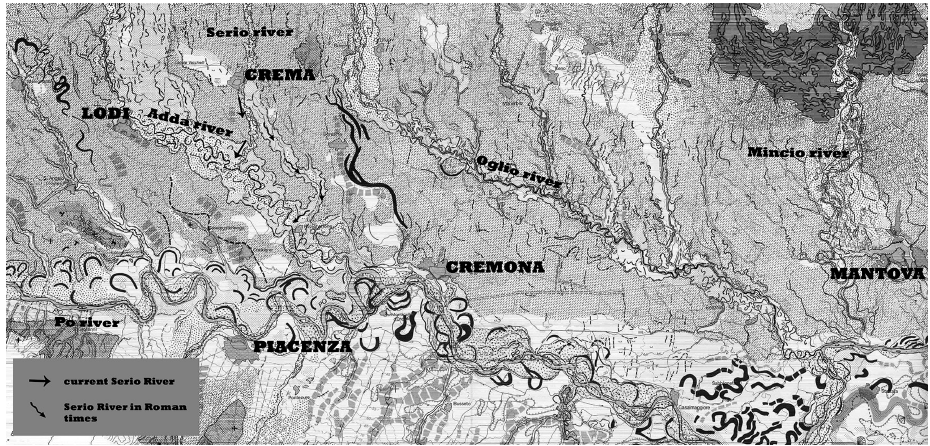
Figure 2: Geomorphologic map of the Pianura Padana (after Carta Geomorfologica della Pianura Padana , Ministero dell’Università e della ricerca scientifica e tecnologica 1997; scientific project: Gio- vanni B.